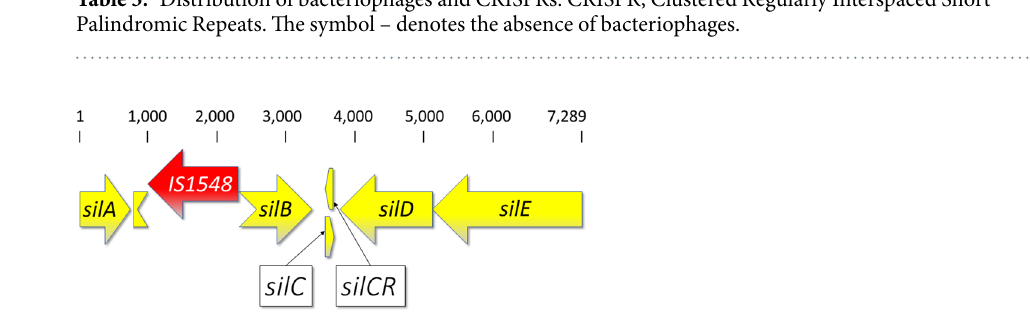
Figure 3. Genetic arrangement of the streptococcal invasive locus in the CC20-isolates. The sil -locus in the CC20 isolates has a transposase, IS 1548 , inserted into the silB -gene. silB encodes a sensory kinase activating the putative DNA response regulator encoded by silA . This leads to increased transcription of the virulence attenuating pheromone encoded by silCR , and suppression of the virulence associated silC -gene. The SilC- peptide is exported from the cell by the transporter-proteins SilD and SilE. Scale indicates nucleotide position. This disrupted sil-locus is deposited in GenBank under the accession code